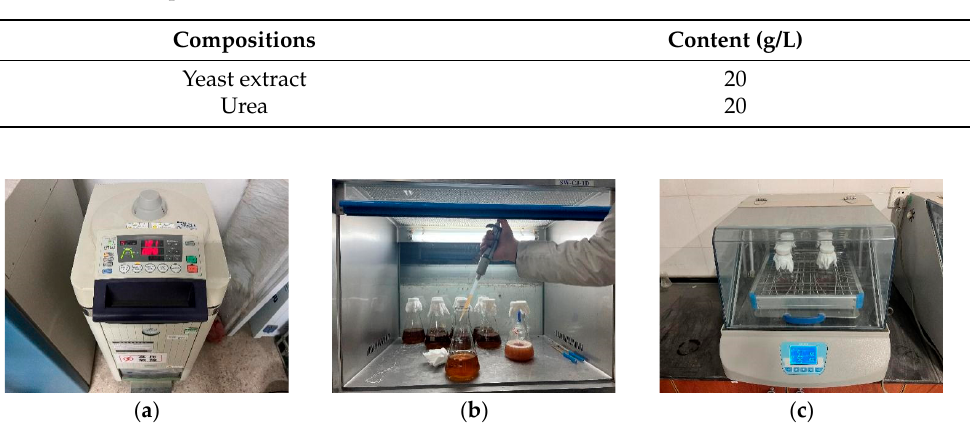
Figure 1. The process of bacteria cultivation: ( a ) autoclave sterilization; ( b ) inoculation in ultra-clean workbench; ( c ) incubation in constant temperature oscillator. workbench; ( c ) incubation in constant temperature